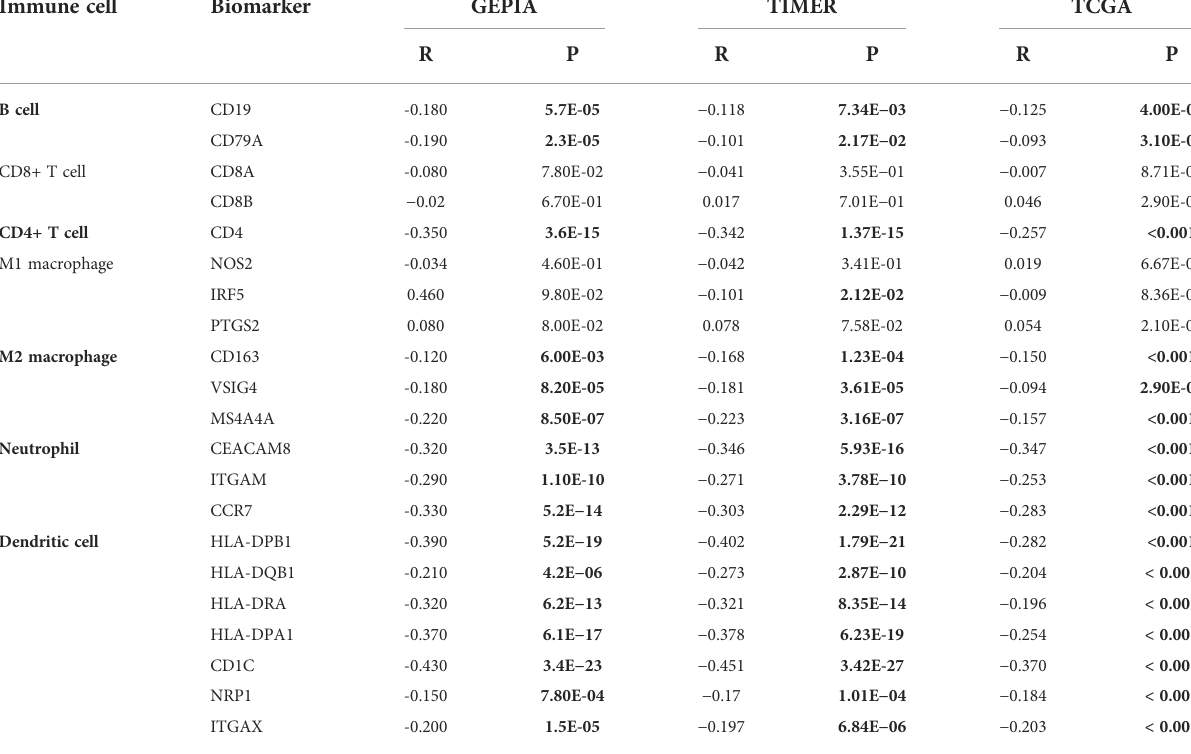
TABLE 3 Correlation analysis between ECE2 and lung adenocarcinoma immune cell biomarkers measured by GEPIA, TIMER and TCGA databases (Spearman correlation test). Immune cell